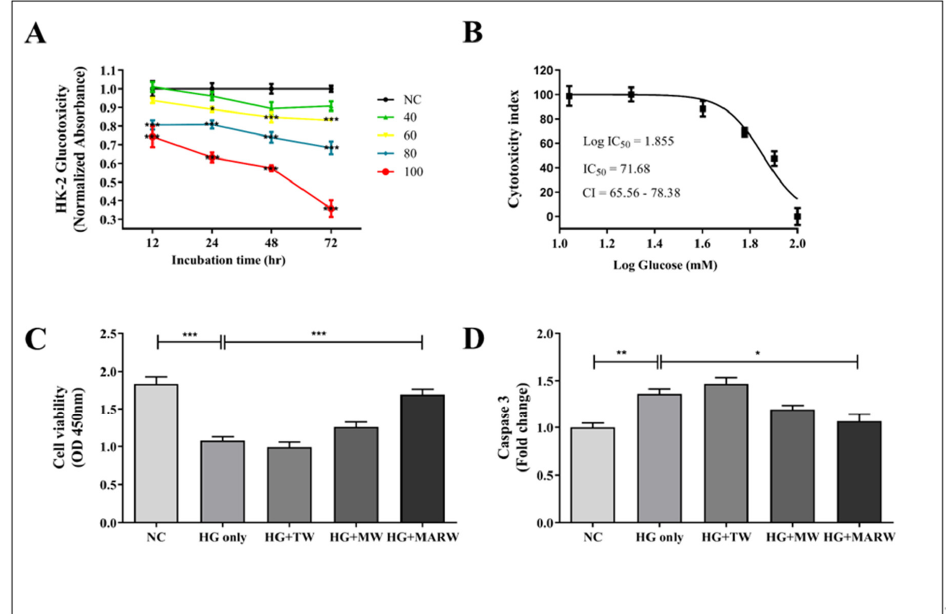
Figure 1. Effects of MARW on cell viability and glucose resorption in HG-induced HK-2 cells: ( A , B ) Cell viability of HK-2 cells treated with different concentrations of D-glucose (NC, 20, 40, 60, 80, 100 mM); ( C ) Cell viability of HK-2 cells treated with 71.68 mM glucose, treated with 10% TW, MW and MARW after 24 h; ( D ) Cleaved caspase 3 was performed by the ELISA. * p < 0.05, ** p < 0.01, and *** p < 0.001 indicate significant differences when tested with Tukey’s ANOVA test. Values represent the Mean ± SEM ( n = 3). Abbreviations: NC, normal control; HG, high glucose; TW, tap water; MW, mineral water; MARW, magnesium-enhanced alkaline-reduced